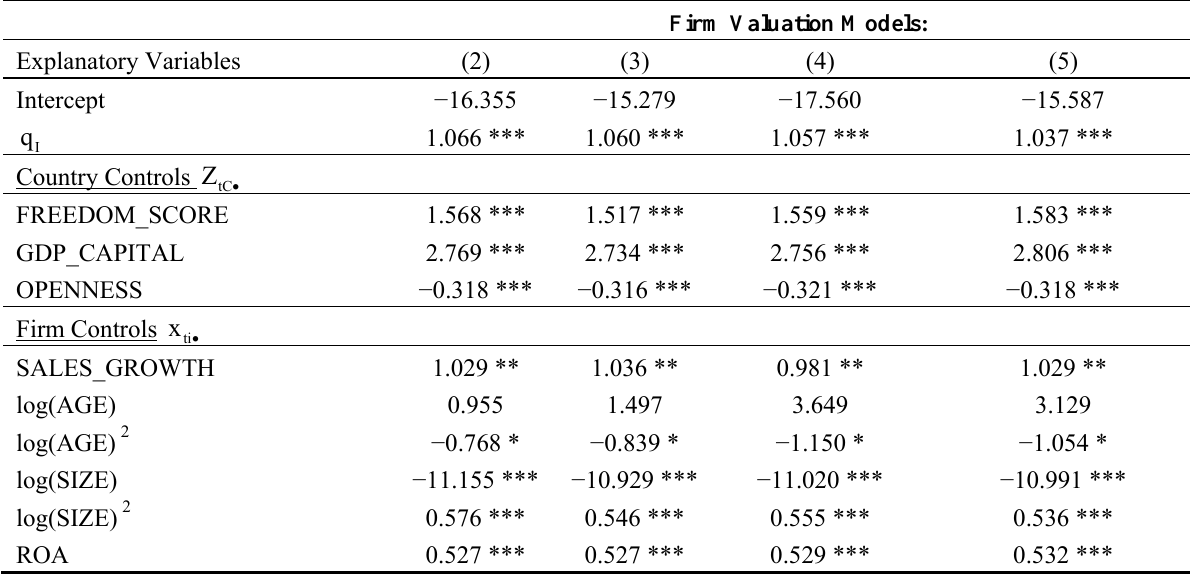
Table 6. Conditional Regressions for Firms with Cross Listings Dependent Variable: Firm’s Tobin’s